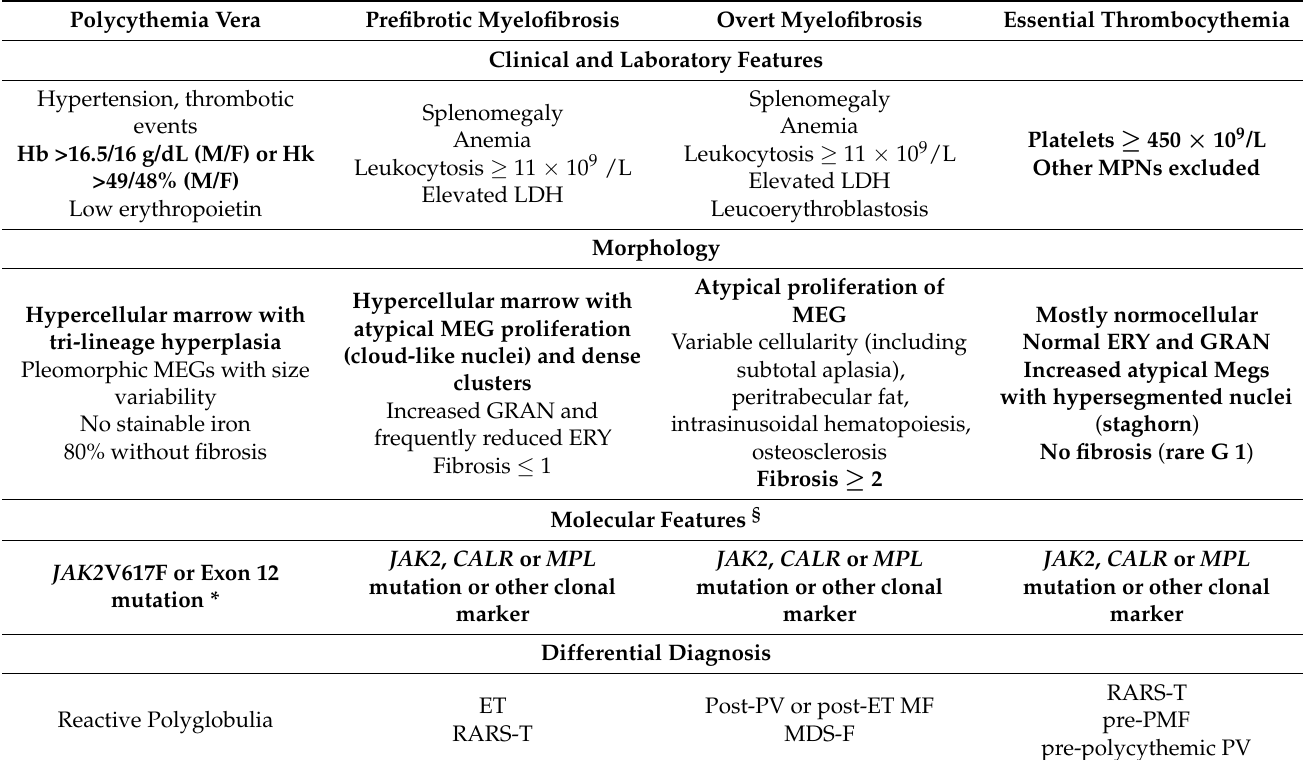
Table 2. Diagnostic criteria for the main Ph − myeloproliferative neoplasms